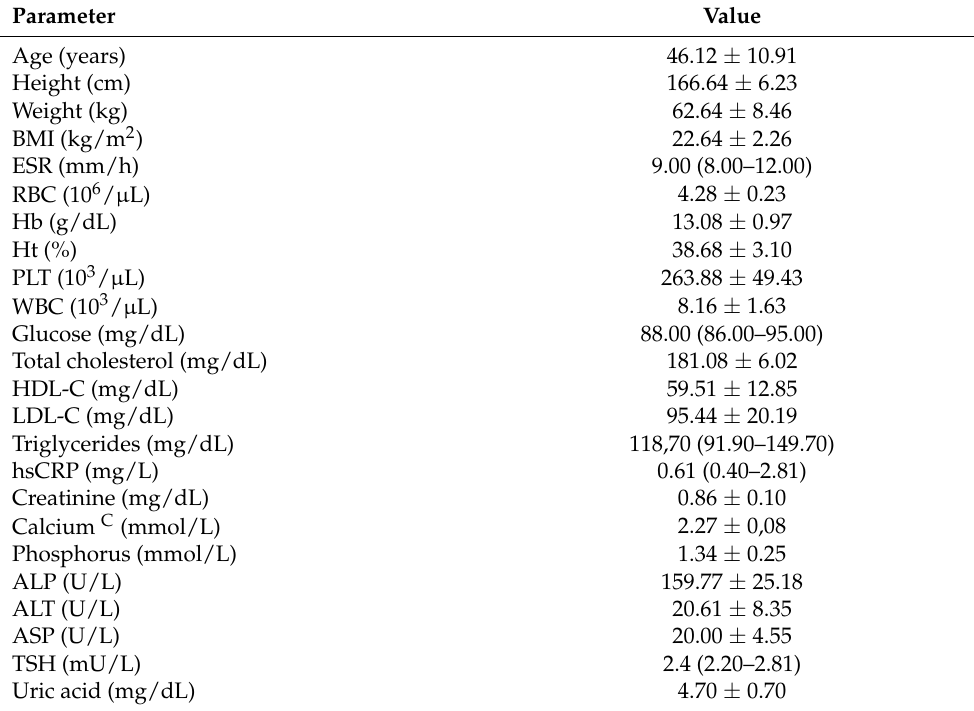
Table 2. Demographic and clinical characteristics of the 26 healthy